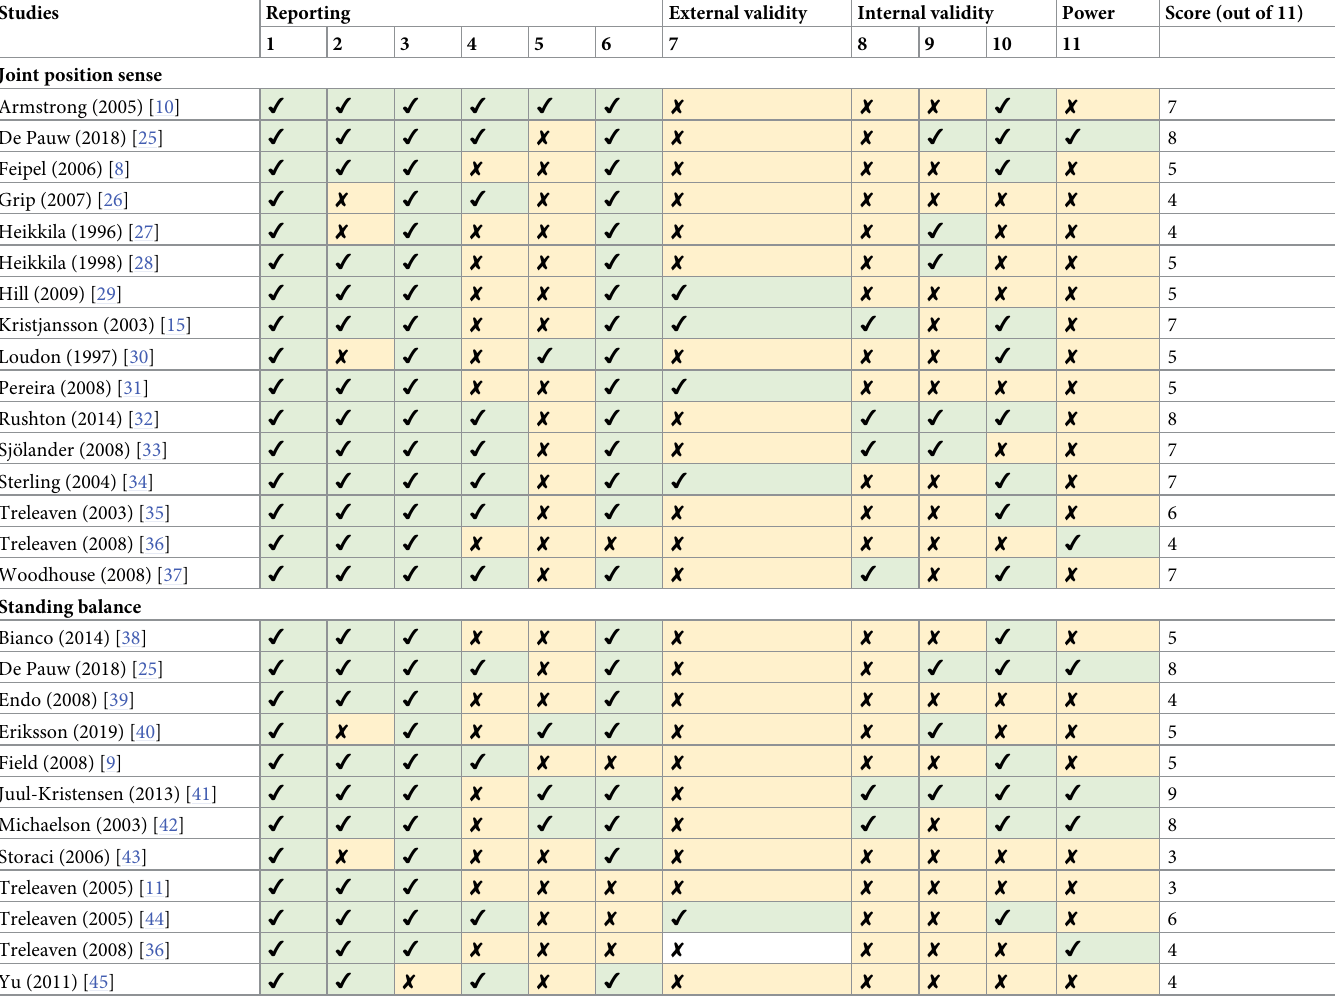
Table 6. Quality rating of included studies using the modified Downs and Black